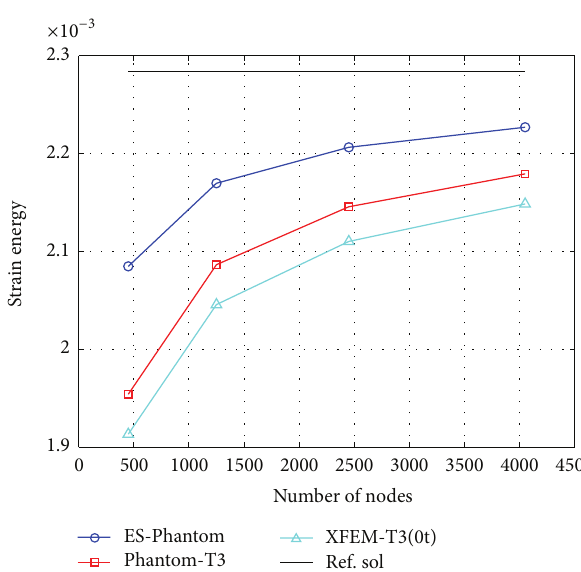
Figure 10: The convergence in the energy norm versus ℎ (mesh size) for the sheet with an edge crack under tension. (𝑘) [1, 2, 4] ; 1 ) = [̃1, 2, 4] (𝑘) . 2 ) =